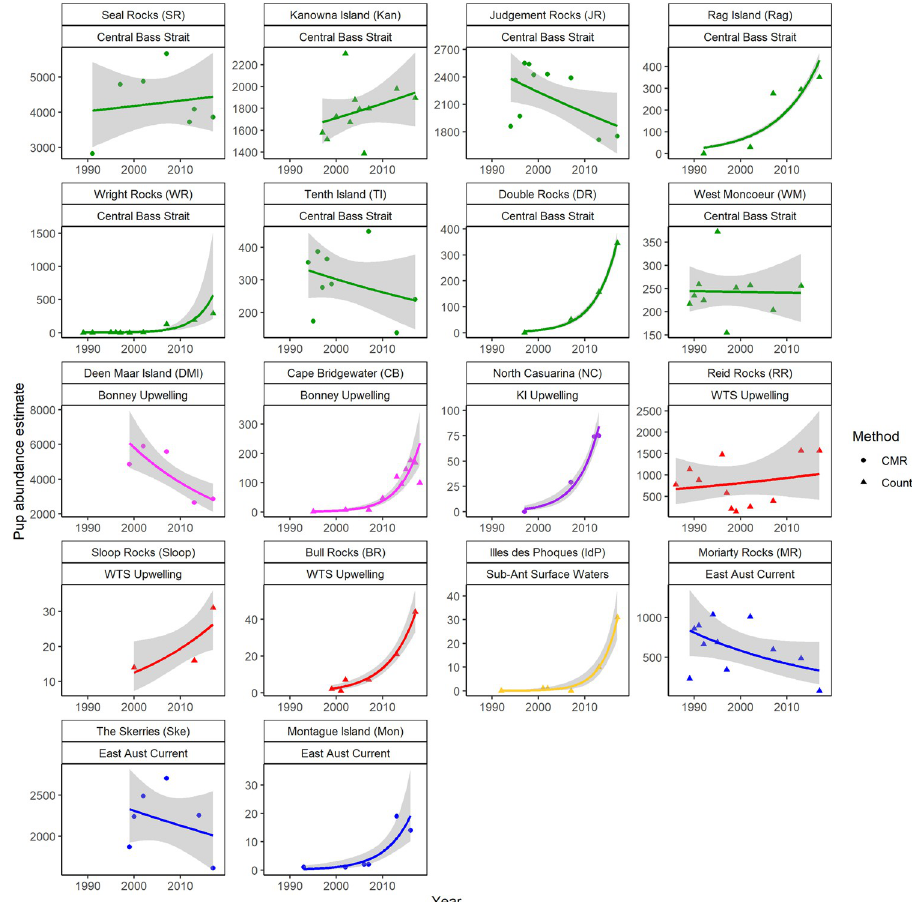
Fig 4. Smoothed predicted curves (solid line) fitted to estimates of live pup abundance of Australian fur seal pups at breeding colonies in south-eastern Australia, estimated using Generalised Linear Models with negative binomial distributions. Colony names with abbreviations in brackets and their associated region (also varying by colour) are identified in the heading of each trend and 95% confidence intervals are shown by the grey shading. Live pup abundance estimates used at each site were determined by a single method: direct count or capture-mark-resight (triangle and circle symbols respectively). The sites are grouped by